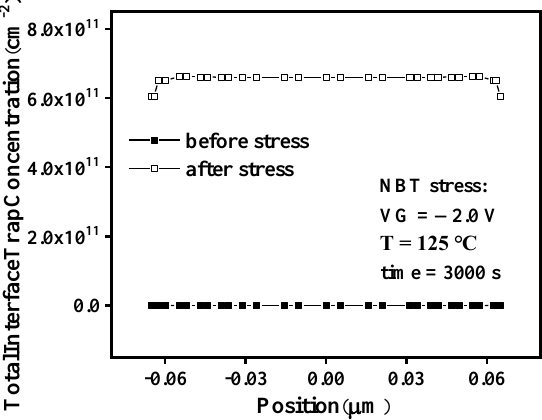
Figure 4. Distribution of interface trap concentration in PMOSFET.